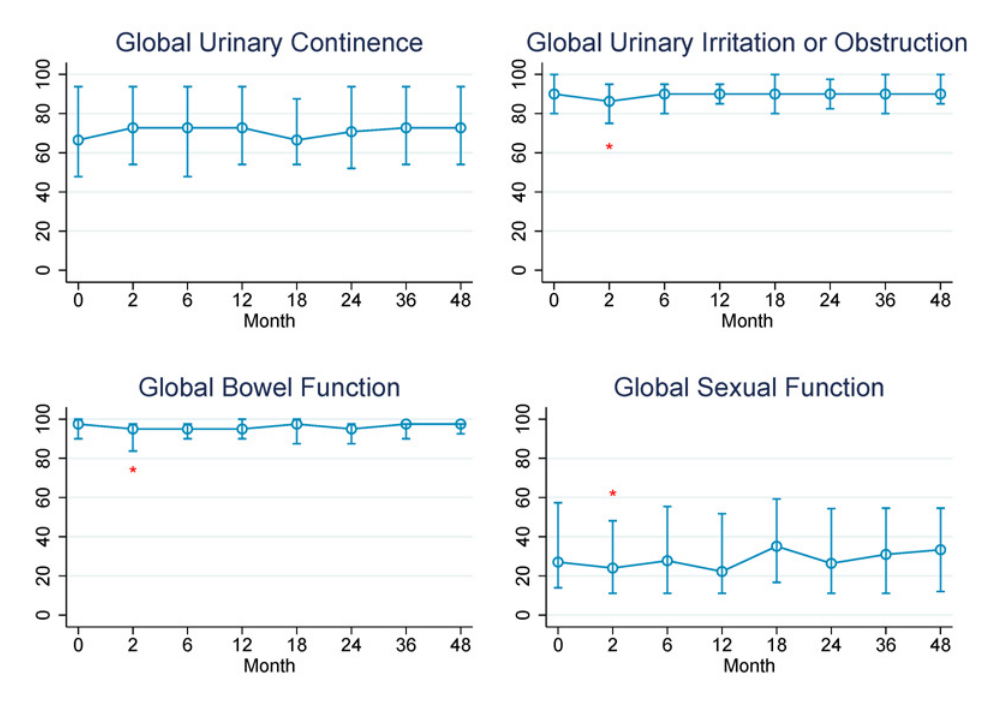
Fig 1. Changes in median QOL scores over time for the entire study cohort. Asterisks designate time points at which scores were significantly worse than baseline ( P < 0.05 by Wilcoxon signed-rank test). Standard error bars represent interquartile